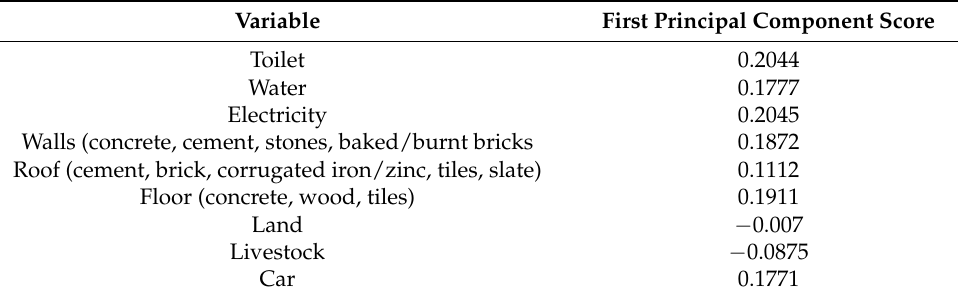
Table A7. Asset Index for Namibia-Results from tetrachoric Principal Components